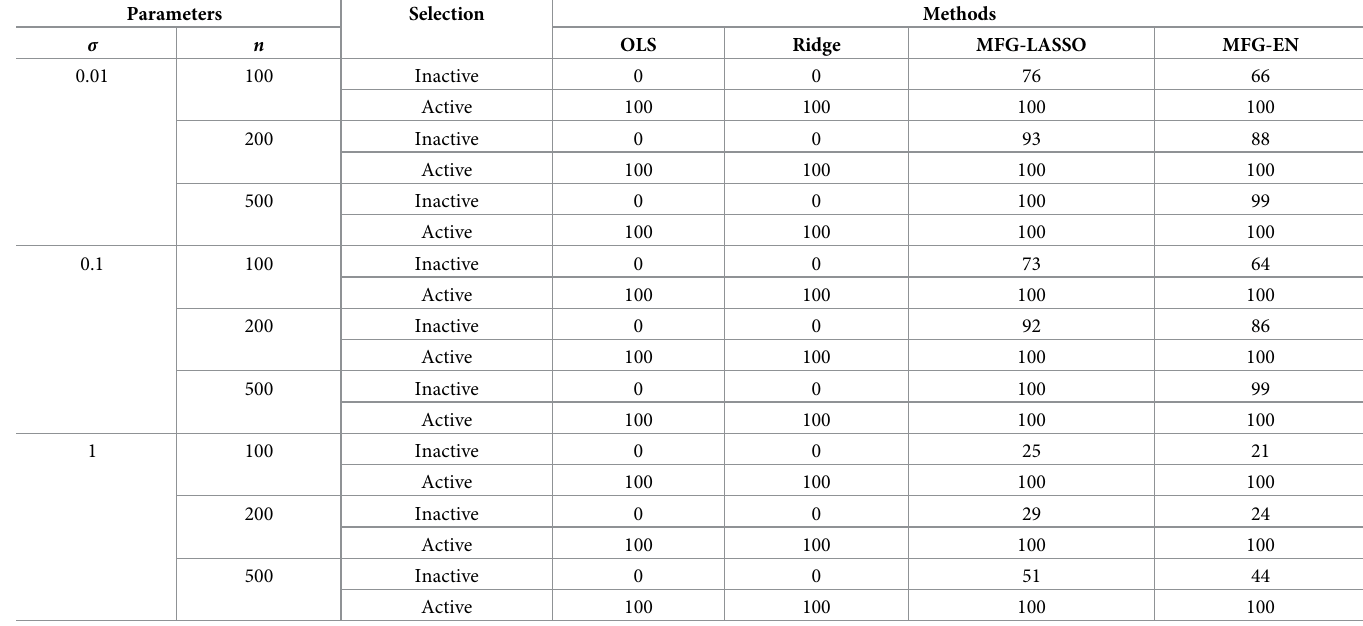
Table 1. Percentages of correct selection in the test set under various simulation scenarios. In each case, 100 random samples are used. In each sample, we count the correctly identified functional predictors for the active set of the size 3 and the inactive set of the size 16. Then, we compute the overall percentage out of 100 samples. Parameters